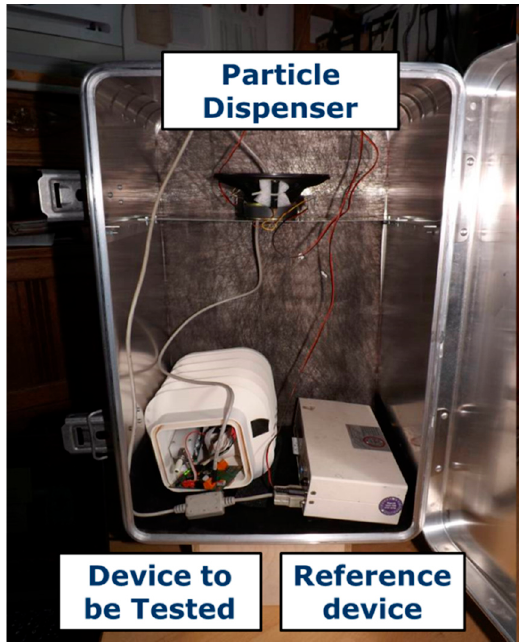
Figure 3. Self-built particle generator as measuring setup for comparison measurements between a reference instrument (Grimm 1.108, bottom right) and URBMOBI 3.0 (bottom/middle left); Photo: Bernd Laquai.